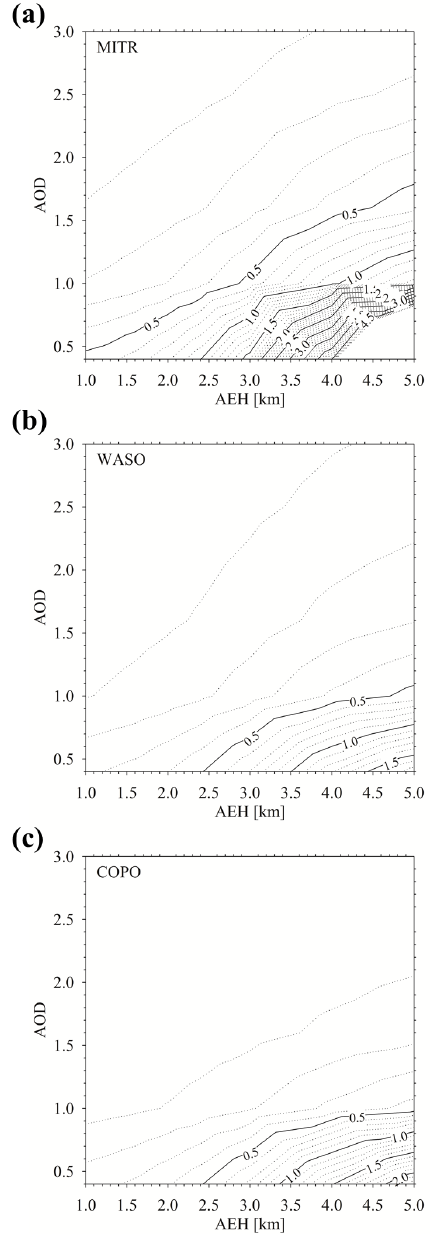
Figure 11. Same as Fig. 7 except for surface albedo difference of